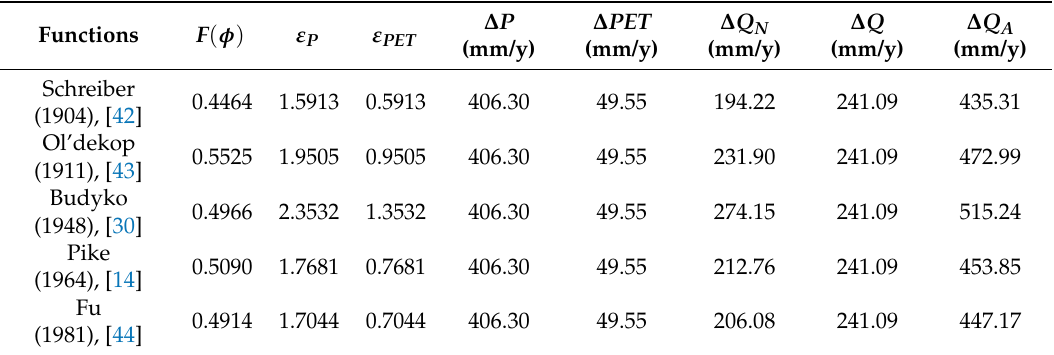
Table 5. Results of the hydrological sensitivity